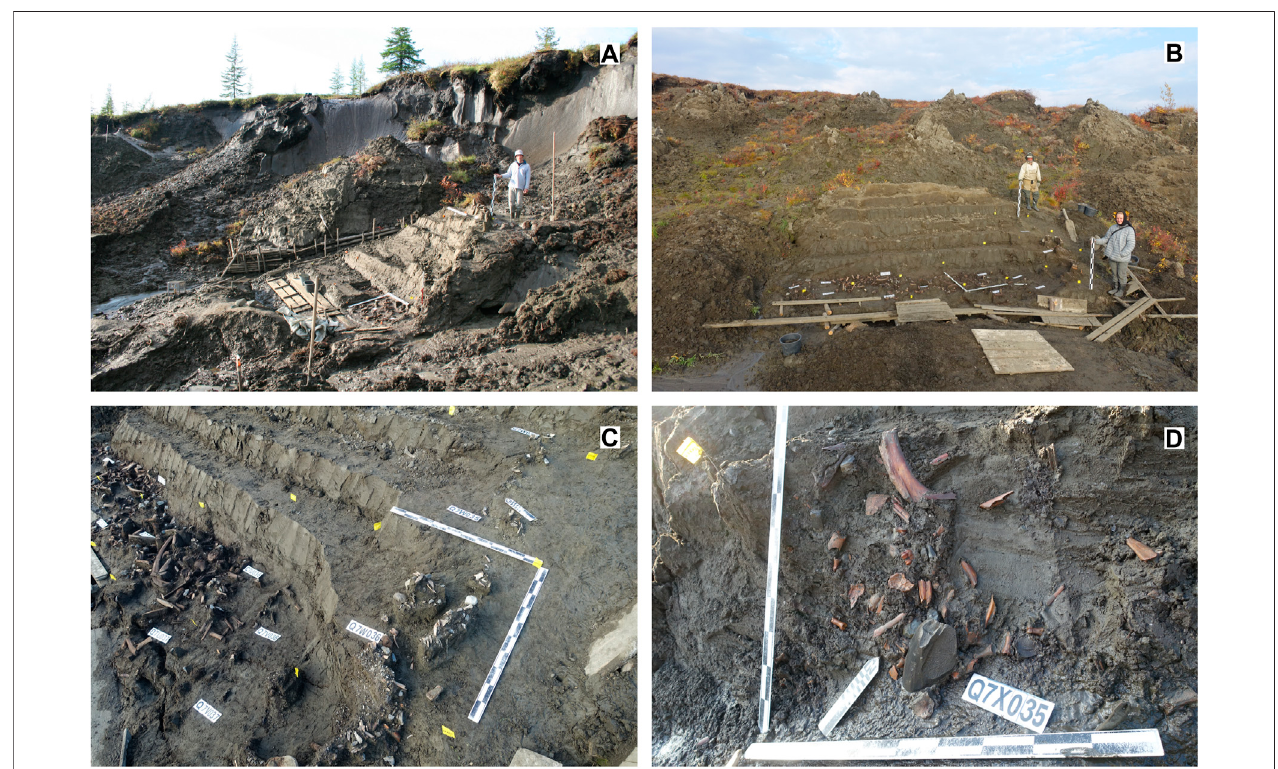
FIGURE 9 | The culture-bearing horizon of the Yana complex of sites: (A) excavations of the Northern point area in 2009: in the front of the central part of the polygon,theculturallayerisopened insubhorizontal positionwhile intherearpart ofthepolygon nexttotheice-wedgecontact theculturallayerisfound2 mhigherdue to vertical deformation caused by the ice-wedge growth; (B) excavations of 2020 at the Yana B area: the cultural layer stretches horizontally in the middle part of the polygon deposit but becomes smashed in its marginal zone gradually taking a vertical position seen in bending and archaeological fi nds that moved upward by ∼ 1.5 m; (C) the same polygon viewed from the North, with a narrow (1 m wide) strip of cultural material taking a position higher than the source level; (D) excavations of 2019, Yana B area, vertical frozen wall at the polygon boundary near the contact zone between the polygon body and the ice wedge, vertical and nearly vertical distribution of archaeological material in the bended part of the layer occurred due to cryogenic deformation of the cultural layer because of the ice-wedge growth after the formation of perennially frozen deposit which included the cultural horizon.